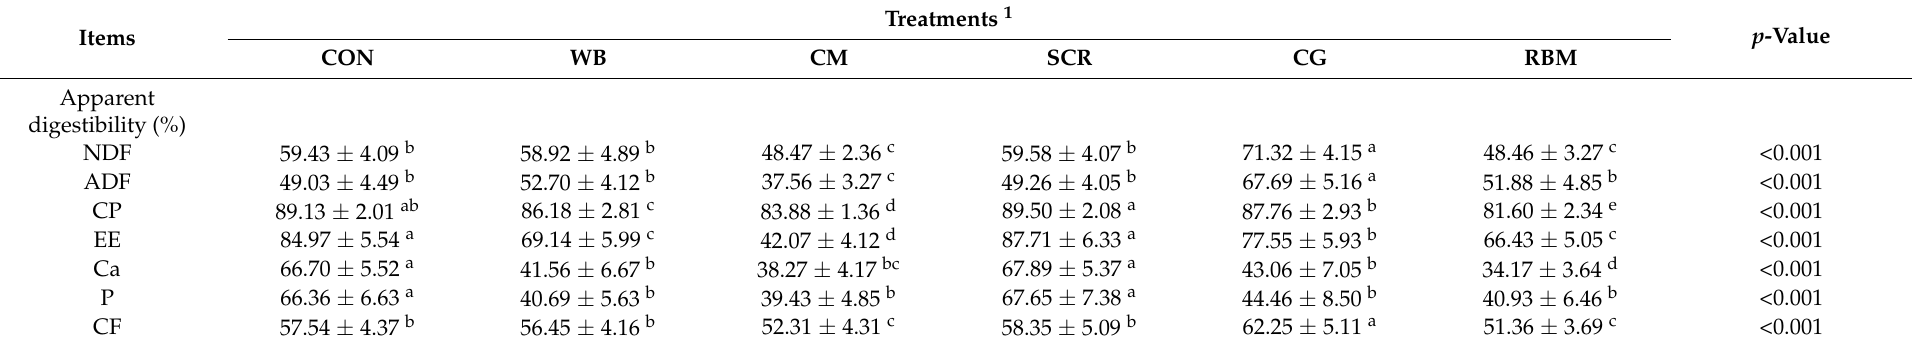
Table 7. Effect of different fiber sources on the apparent total tract digestibility of nutrients during